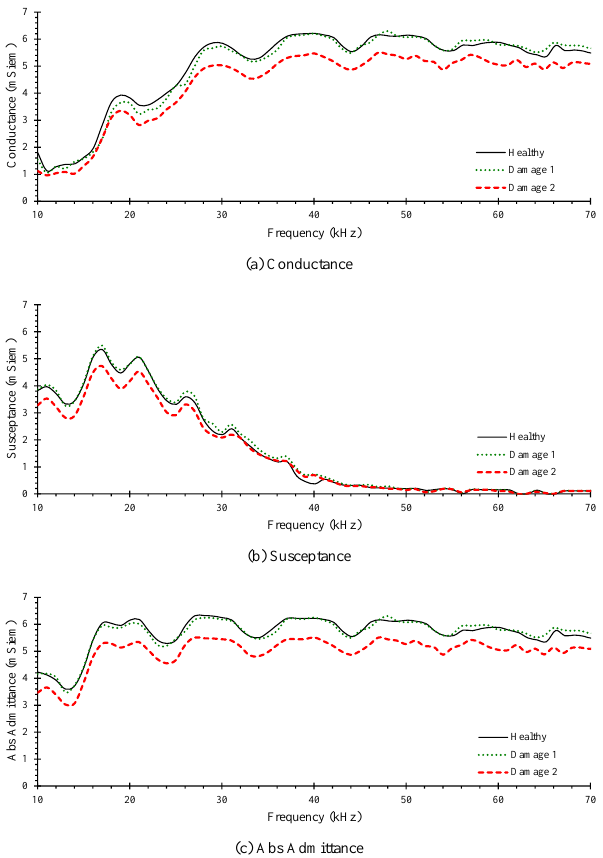
Figure 6. Comparisons of the embedded “smart aggregate” transducer PZT2 measurements of Figure 6: Comparisons of the embedded “smart aggregate” trans- admittance (conductance, susceptance and abs admittance) between the healthy state and the ducer PZT2 measurements of admittance (conductance, suscep- two damage levels (Damage 1 and Damage 2) of the RC beam tance and abs admittance) between the healthy state and the two damage levels (Damage 1 and Damage 2) of the RC beam